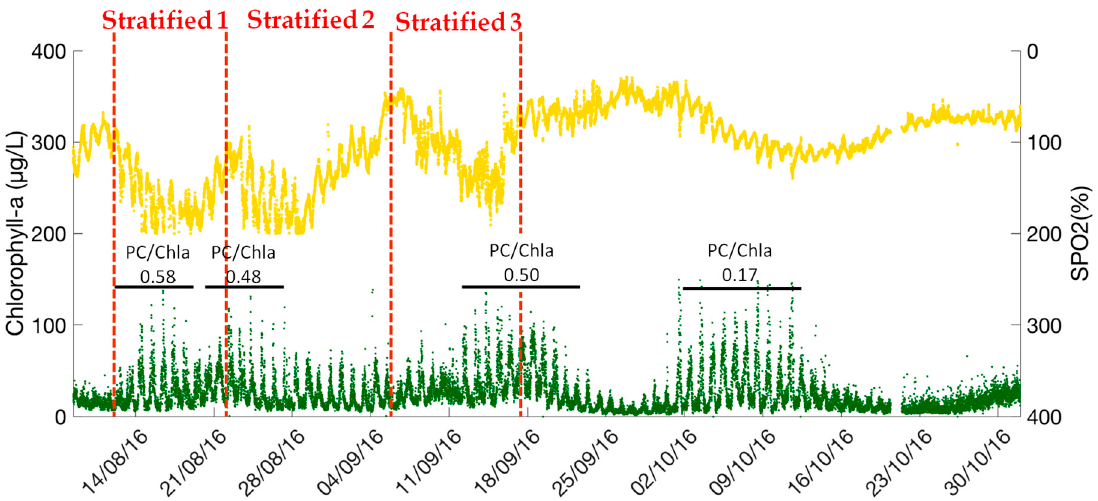
Figure 6. Dissolved oxygen saturation (upper—reversed y axis) and chlorophyll-a concentration (lower) with average phycocyanin to chlorophyll-a ratio (black horizontal bar) at 1.5 m depth of the point B from 8 August 2016 to 31 October 2016.